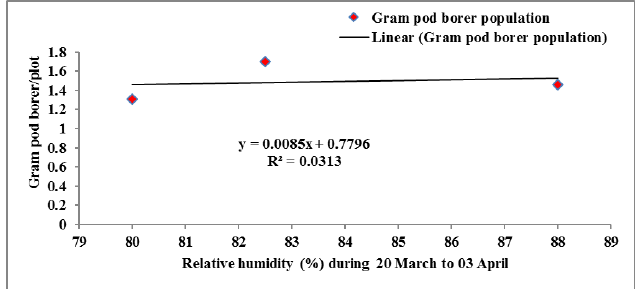
Figure 4: Relationship between the population of gram pod borer and humidity